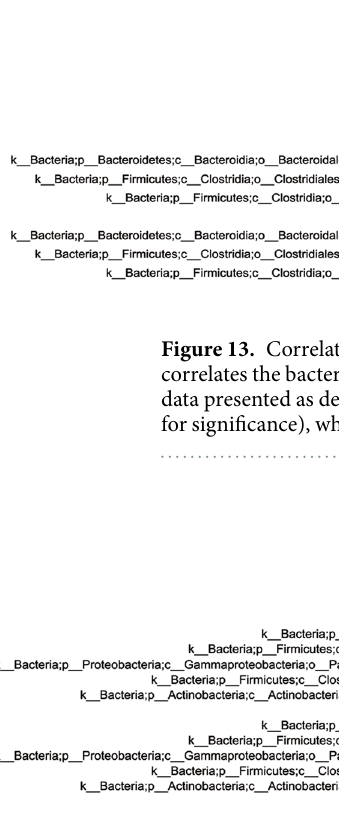
Figure 14. Correlations of fecal microbiota changes and EPM results in AgNS and control groups. This figure correlates the bacterial changes identified with LEfSe (Fig. 8) and the EPM results (Fig. 5). The correlations and data presented as detailed in Fig. 9. However, the values without a box only showed a statistical trend (P ≤ 0.1 for significance), whereas those with a black box were significant (P ≤